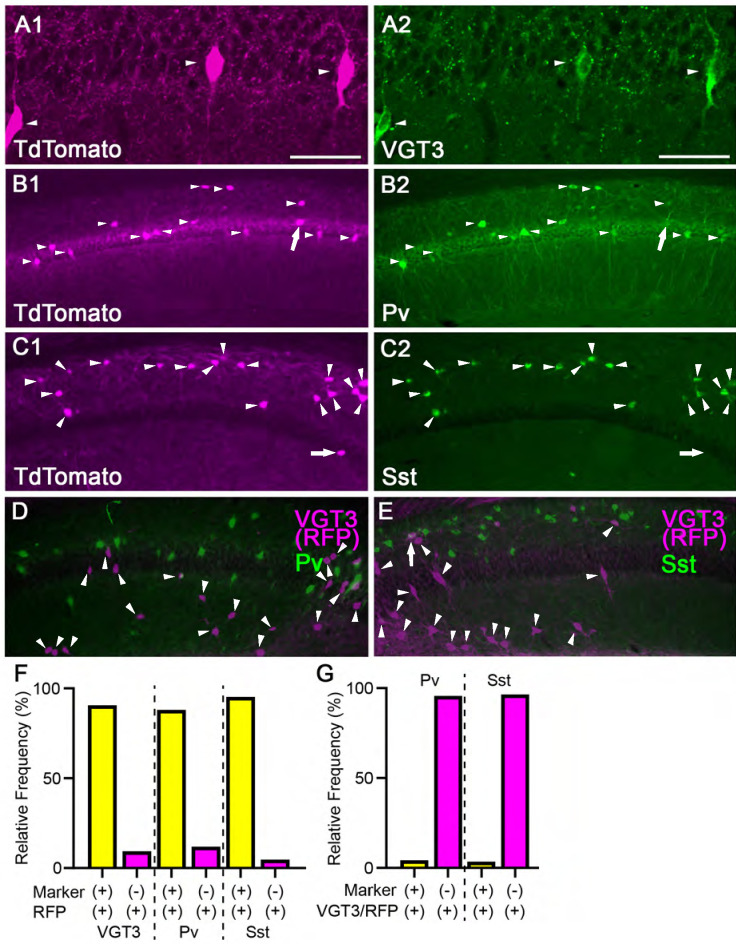
Validation of TdTomato expression in three different cell type-specific fluorescent lines.(A–C) Images of double-labeled immunofluorescence staining against TdTomato (red, A1, B1, and C1) and cell type-specific markers (green, VGT3: A2, Pv: B2, Sst: C2) in the hippocampal CA1 region of VGT3/RFP (A), Pv/RFP (B), and Sst/RFP (C) mice. (D and E) Images of double-labeled immunofluorescence staining against TdTomato (magenta) and cell type-specific markers (green, Pv: D, Sst: E) in the hippocampal CA1 region of VGT3/RFP mice. (F) Relative proportion of hippocampal CA1 inhibitory interneurons as a fraction of neuronal populations positive for cell type-specific markers and TdTomato (+) and TdTomato-positive but marker negative (−) neurons. The TdTomato-positive neurons included for quantification were localized in the specific CA1 subregions where we performed electrophysiological recordings; VGT3/RFP mice: CA1 pyramidale, radiatum, and oriens; Pv/RFP: radiatum; Sst/RFP: oriens. Number of TdTomato-positive neurons: VGT3/RFP: 404 neurons/2 mice; Pv/RFP: 1601/2; Sst/RFP: 1789/2. (G) Relative proportion of hippocampal CA1 inhibitory interneurons in VGT3/RFP mice as a fraction of neuronal populations positive for Pv or Sst and TdTomato (+) neurons. Number of TdTomato-positive neurons: Pv/RFP staining: 1966/2; Sst/RFP: 1464/2. Scale bars, 50 µm.